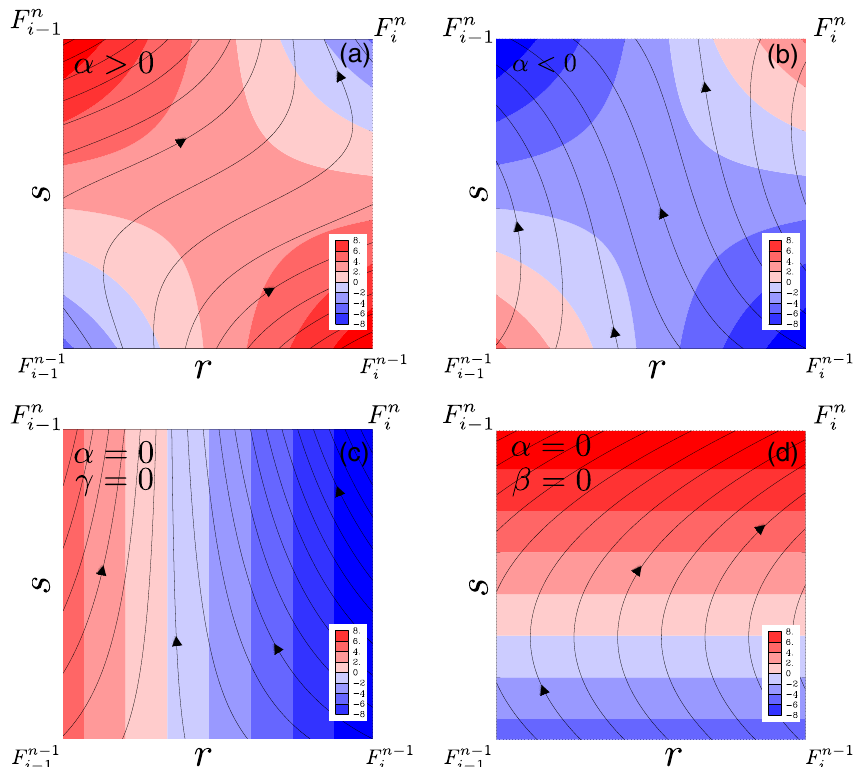
Figure 2. Examples of how trajectories calculated with the time-dependent scheme evolve as a function of the transport F in the space interval r i − 1 < r < r i and in the time interval s n − 1 < s < s n , which hence corresponds to an interval between two GCM outputs ( (cid:49)t G ) and of a grid box ( (cid:49)x , (cid:49)y or (cid:49)z ). The colour shows the transport values F obtained by the bilinear interpolation between the four corners ( F n F n − 1 F n F n α > 0 with two corners of transport in the negative direction (F < 0 ) , which correspond to westward, southward i , i and i − 1 ). (a) or downward directions, and one corner flowing in the opposite direction. (b) α < 0. (c) α = 0 and γ = 0 correspond to the stationary fields, which results in an F field that only changes in the (r) direction. (d) α = 0 and β = 0 correspond to the constant fields in space but which vary in time. Note that the F = 0 line between the red and blue colours corresponds to static flow, which results in “vertical” trajectories in the